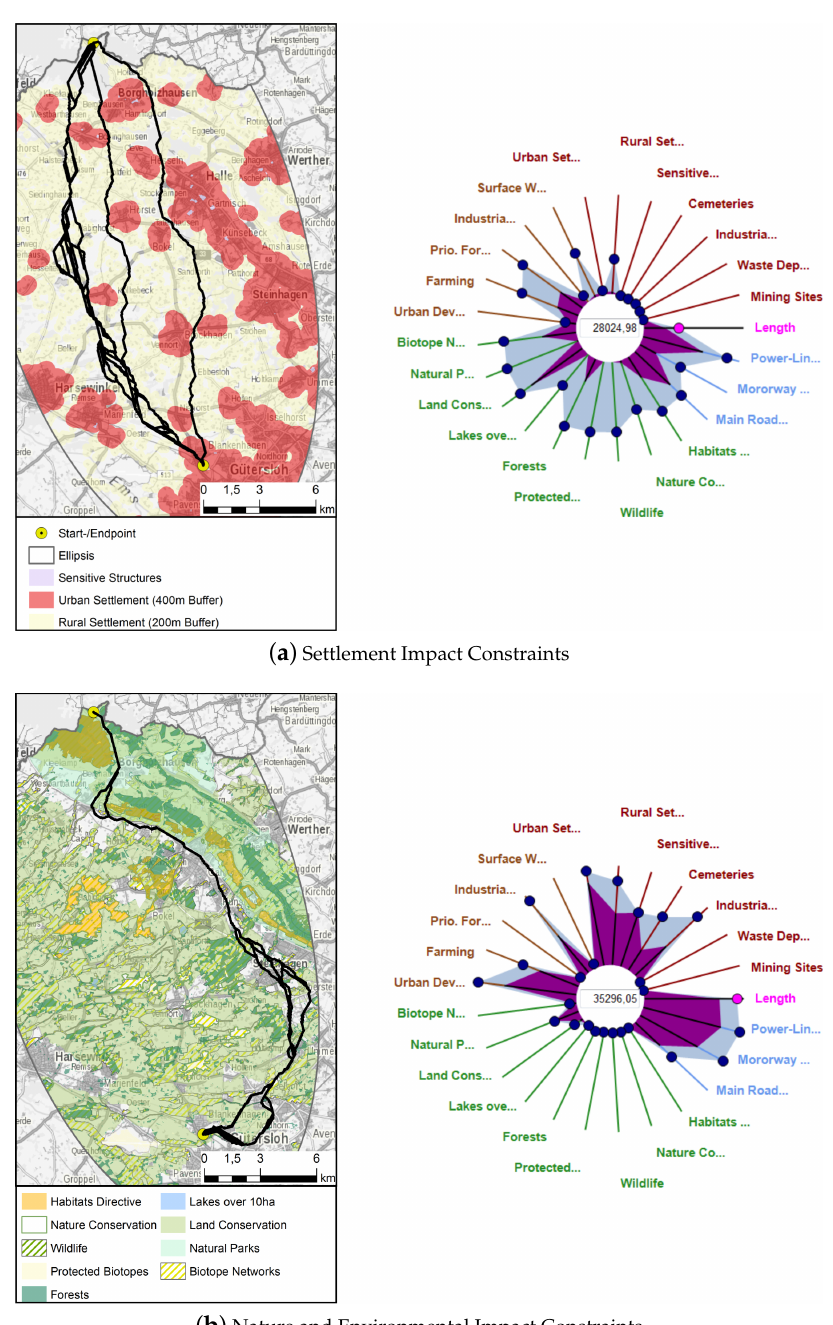
Figure 8. Using the interactive visualisation tool to set constraints on the approximation of the Pareto-front: ( a ) Minimum Settlement Impact Constraints: Maximum crossing length for mining sites, waste deposition sites, cemeteries and sensitive structures are set to zero. Maximum crossing length of urban settlement buffers is restricted to 1.8km; ( b ) Minimum Nature and Environmental Impact Constraints: Crossing of habitats directive areas, water bodies greater than 10ha, protected biotopes and wildlife areas are constrained to zero. The impact on forests is limited to crossing length below 500m and crossing length with land conservation areas is limited to